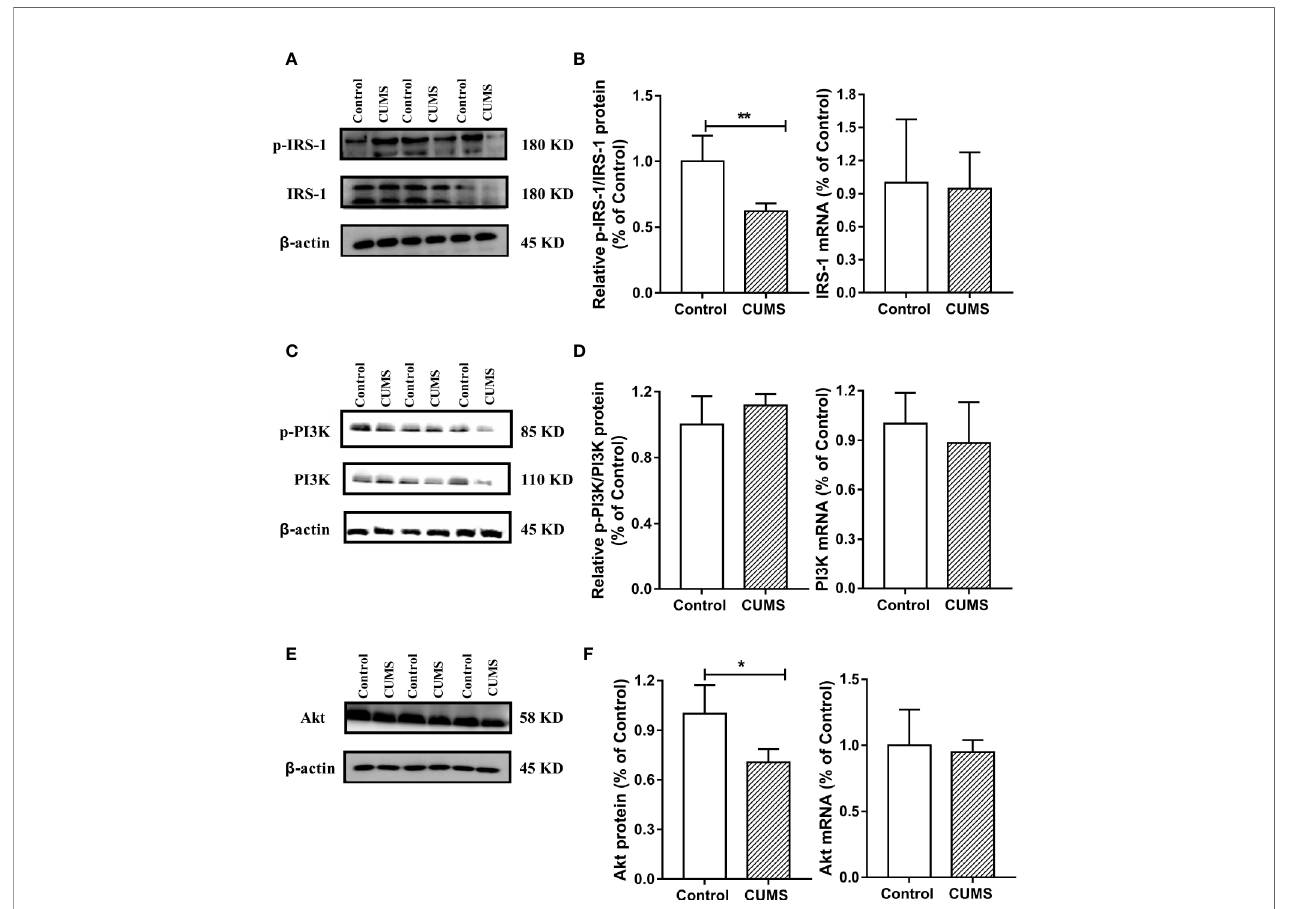
FIGURE 8 | Effect of CUMS exposure on IL-6-mediated insulin signaling in the hypothalamus of rats. (A) The p-IRS-1 and IRS-1 protein representative images for immunoblots. (B) Relative p-IRS-1/IRS-1 protein and mRNA levels of IRS-1. (C) The p-PI3K and PI3K protein representative images for immunoblots. (D) Relative p- PI3K/PI3K protein and mRNA levels of PI3K. (E) The Akt protein representative images for immunoblots. (F) Protein and mRNA levels of Akt. Data are presented as mean ± SD, n = 6; *p < 0.05, **p < 0.01 vs. Control